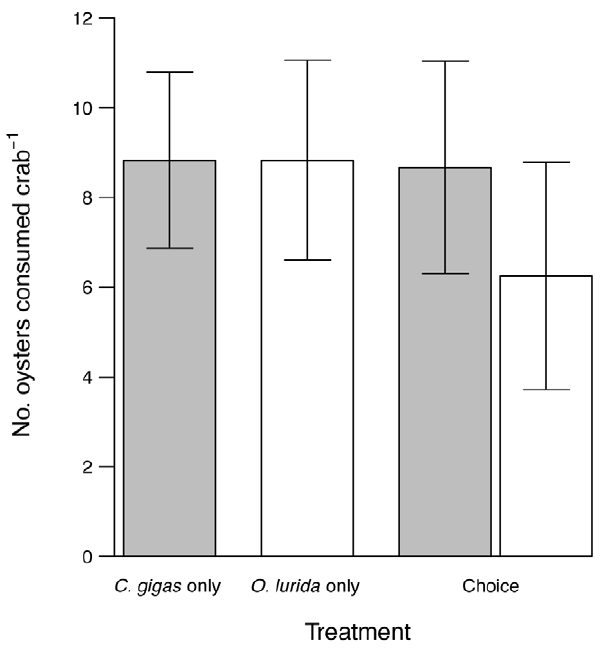
Figure 2. Crab feeding rates and preference on native and non- native oysters. Number (mean 6 SE) of oysters consumed by crabs over 24 hours in the oyster preference experiment. Gray bars are Crassostrea gigas , Pacific oysters, and white bars are Ostrea lurida , Olympia oysters. Crabs were randomly assigned to one of three treatments (n=12): (1) 25 C. gigas only, (2) 25 O. lurida only, or (3) the treatment labeled ‘‘Choice’’, 25 C. gigas and 25 O. lurida .